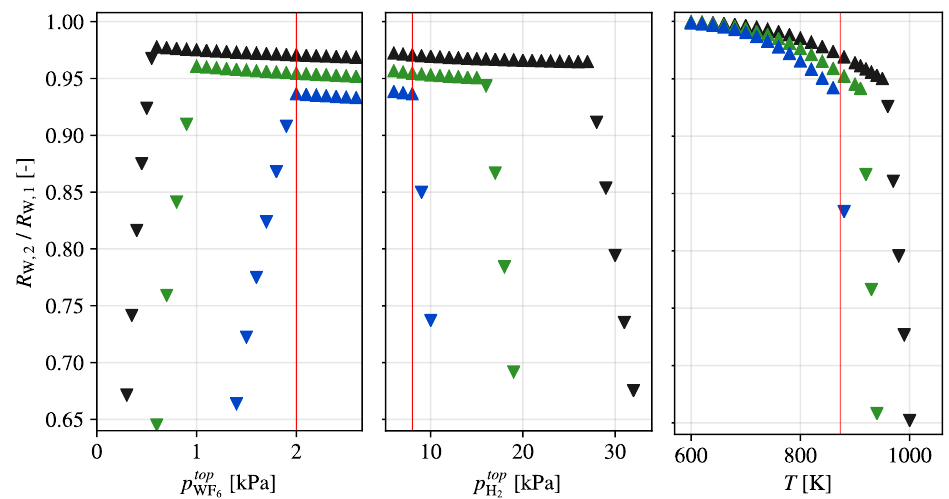
Figure 6. Parameter study results: R W,2 / R W,1 (explained in Figure 4b,c) vs. p top , p top and T . The WF 6 H 2 results are plotted either with a (cid:77) or a (cid:79) symbol, depending on whether the deposition rate deep inside the pore ( R W,2 ) are independent of p WF (Equation (4)) or dependent on p WF (Equation (3)), 6 6 respectively. The constant parameters, if not varied, were T = 873K, p top = 2kPa, p top = 8kPa, WF 6 H 2 marked as red lines, and p inlet = 2kPa. The series correspond color-wise to the different geometries, HF as shown in Figure 4b, representing the pseudo time